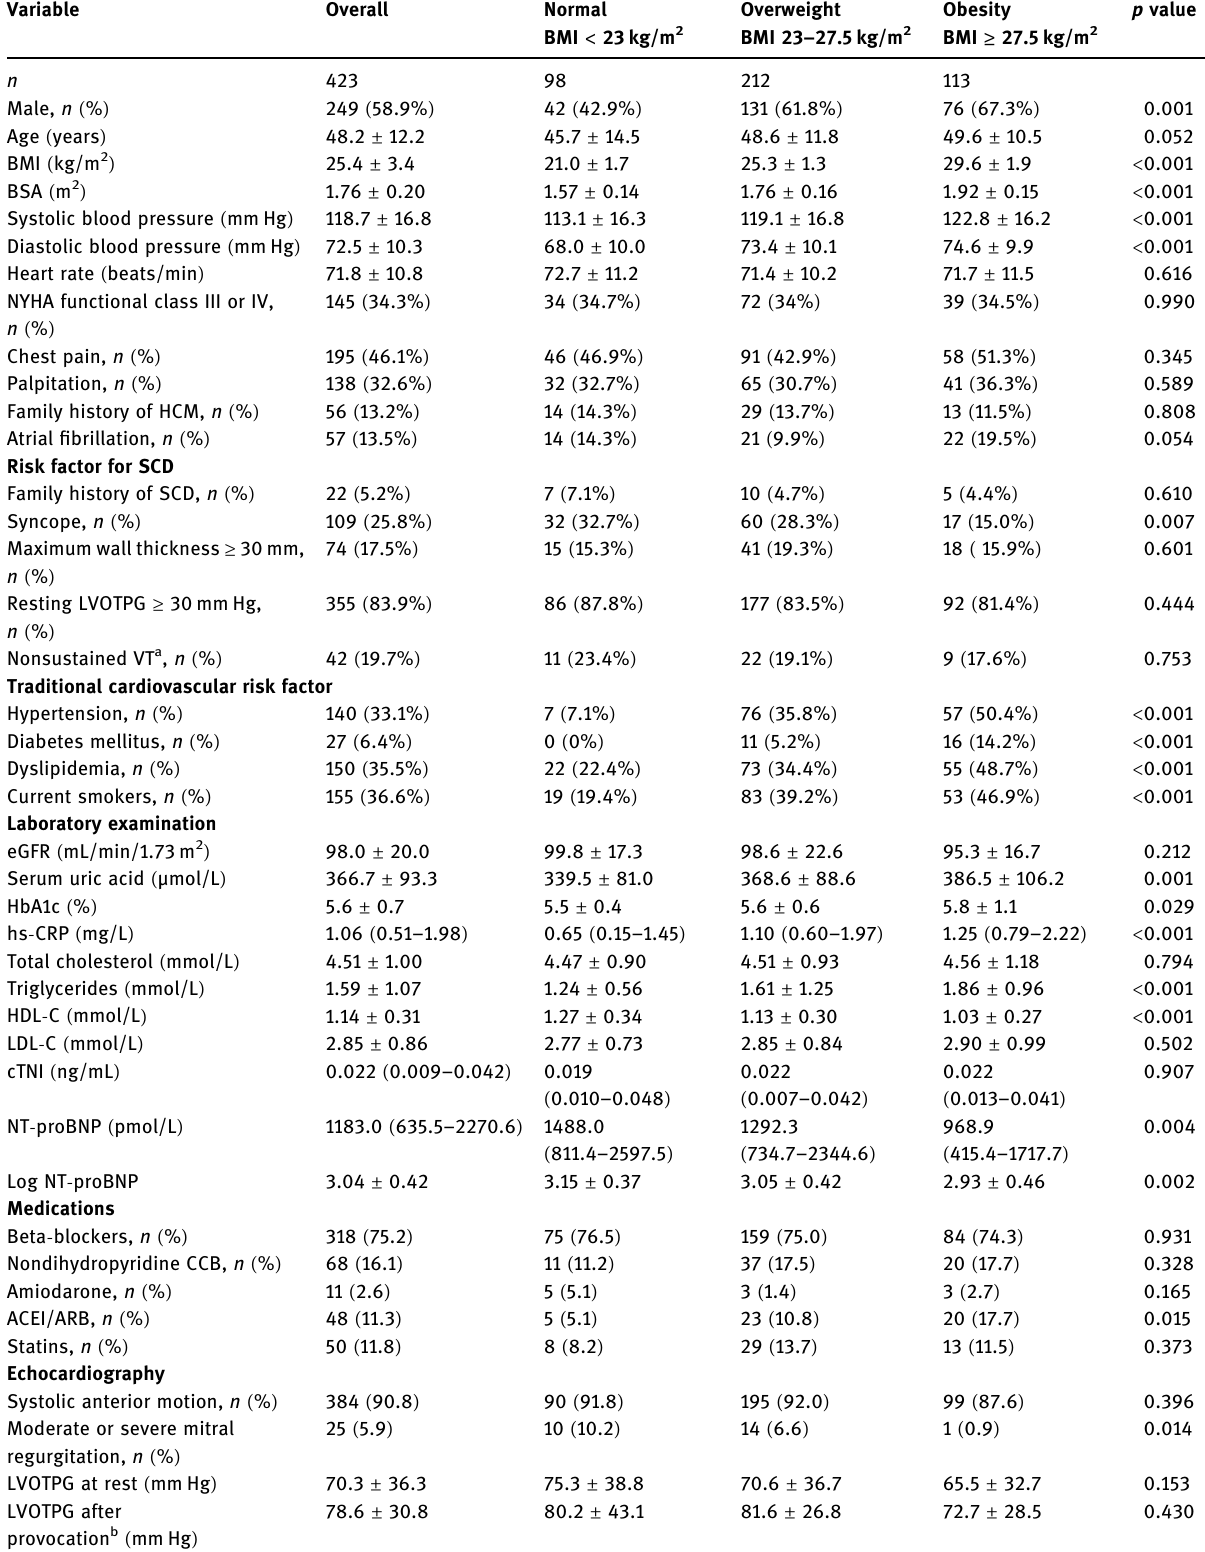
Table 1: Demographic and clinical characteristics of patients with hypertrophic obstructive cardiomyopathy strati fi ed by